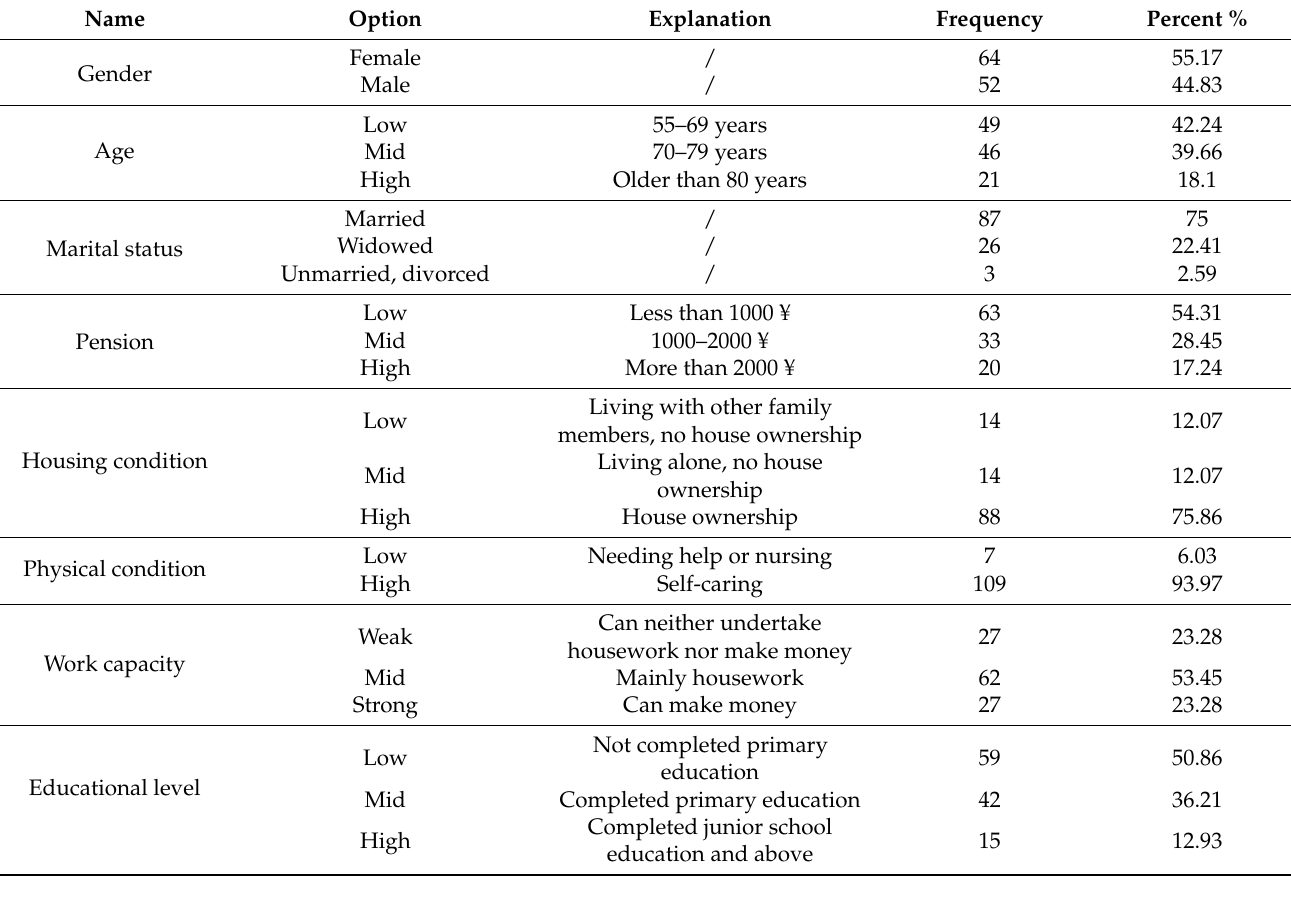
Table 2. Basic demographic information and population attributes of the survey sample (N = 116).